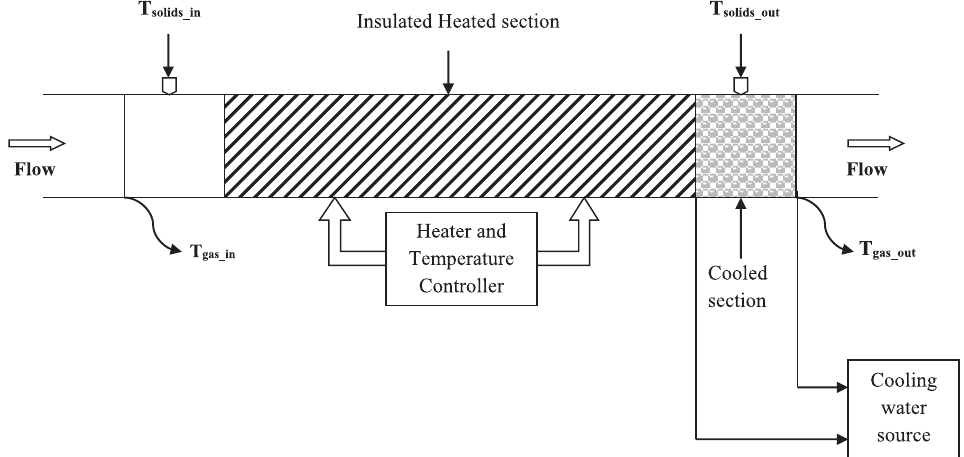
Fig. 2 Schematic diagram of the thermal mass flow